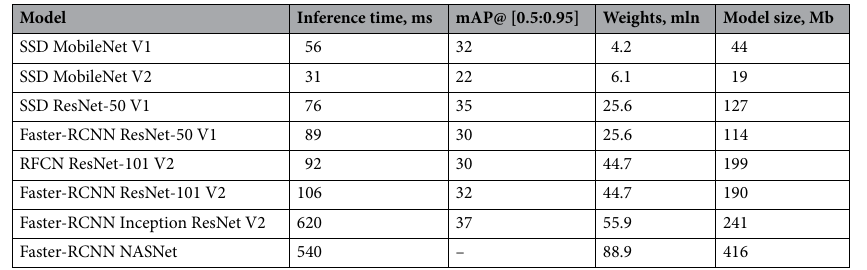
Table 2. Brief characteristics of the use.